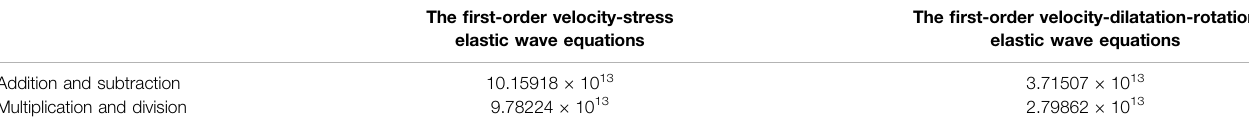
The fi rst-order velocity-stress elastic wave equations